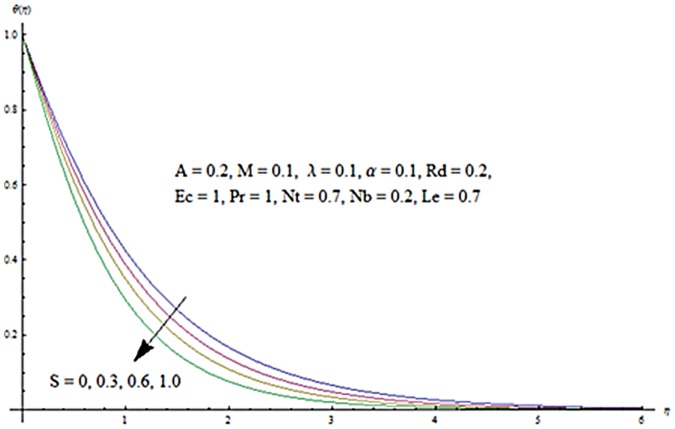
Influence of S on θ.